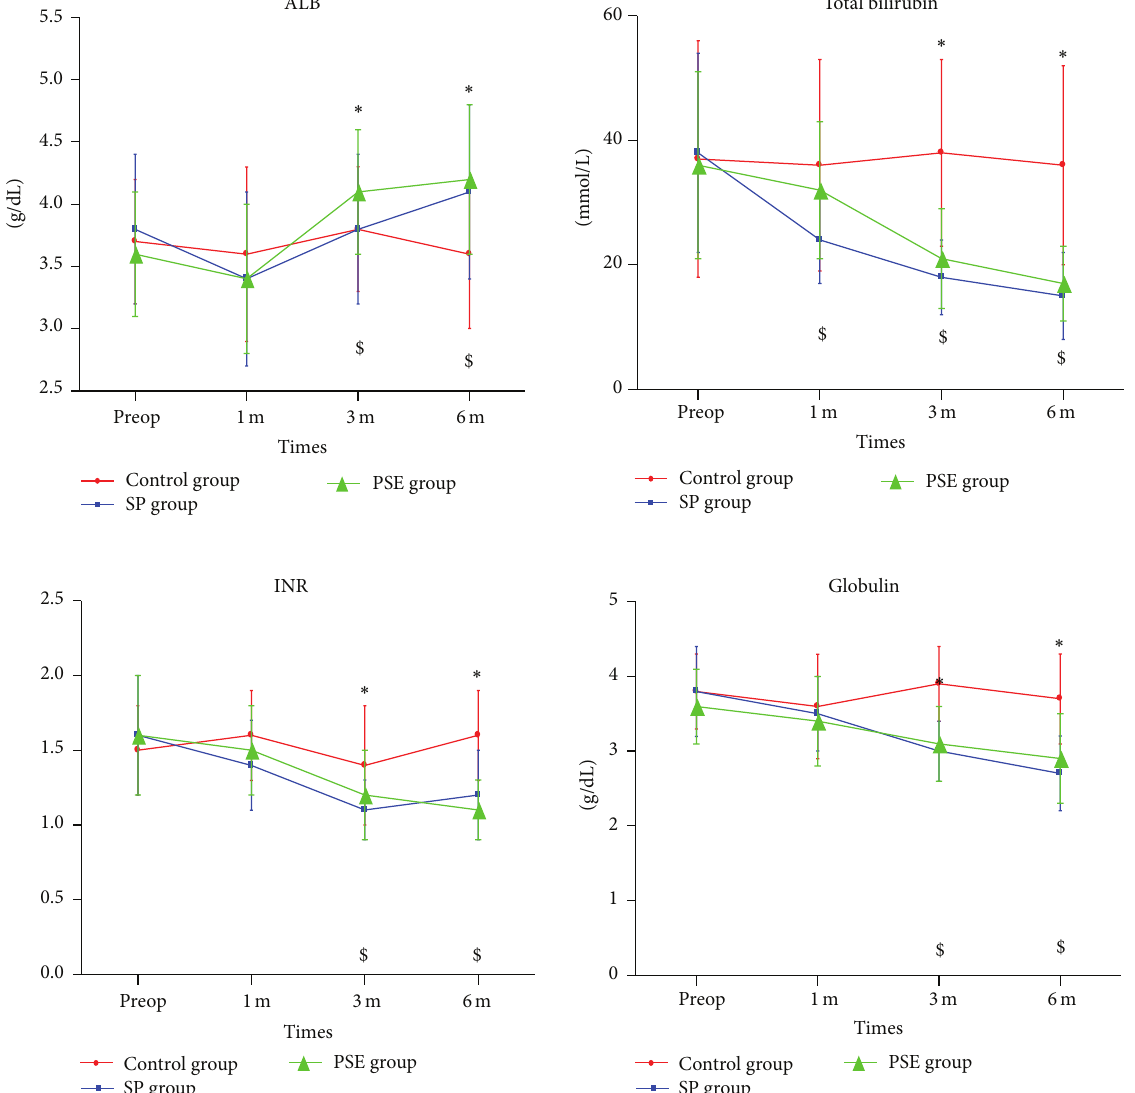
Figure 3: Serum albumin (ALB), total bilirubin, international normalized ratio (INR), and globulin before and after the procedure. ( ∗ indicates significant difference compared with the baseline in the PSE group, 𝑃 < 0.05 ; $ indicates significant difference compared with the baseline in the SP group, 𝑃 < 0.05